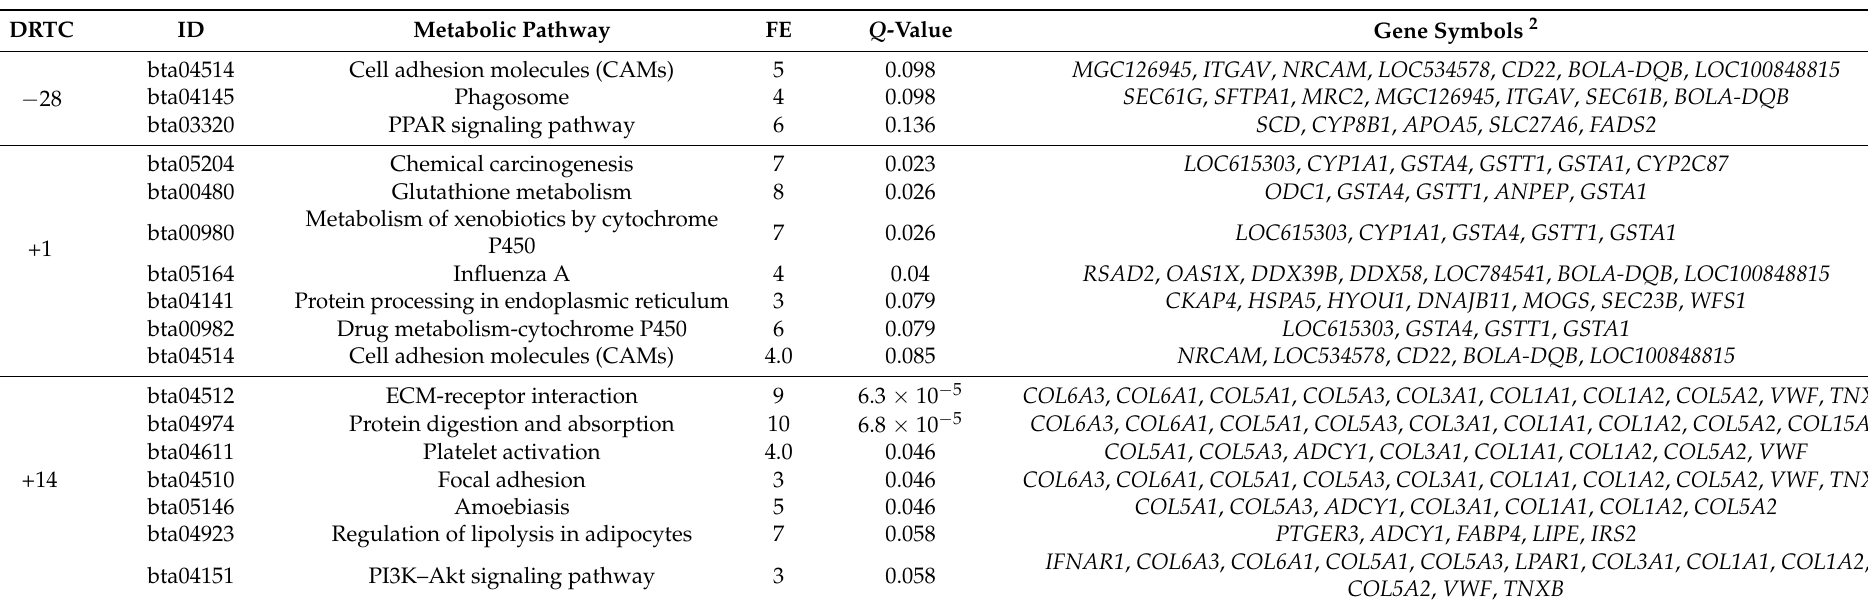
Table 3. Kyoto Encyclopedia of Genes and Genomes metabolic pathways enriched within the genes with significant or marginal evidence of differential expression in liver samples from cows less or more susceptible to lipid-related metabolic disorders 1